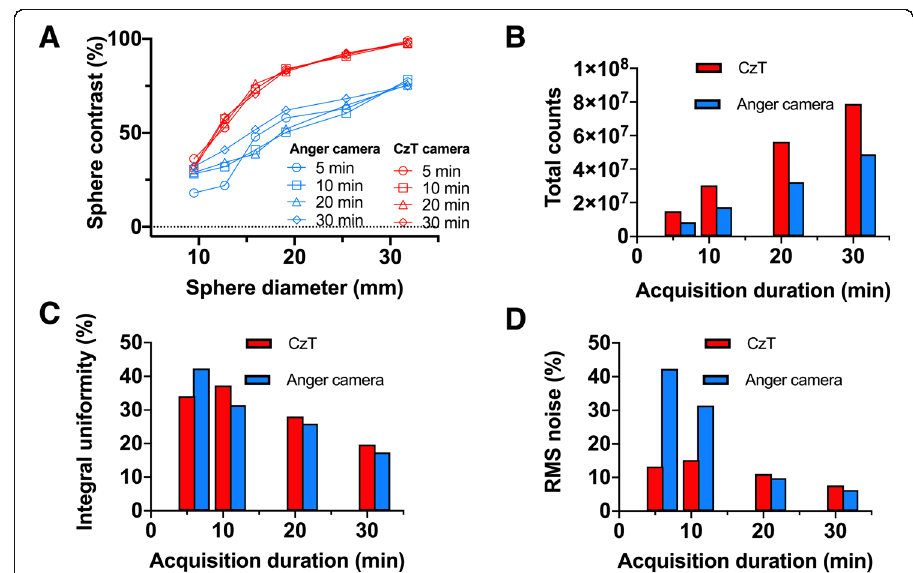
Fig. 4 Image contrast measured as a function of sphere diameter at different acquisition times for CzT and Anger cameras ( a ). Total recorded counts ( b ), integral uniformity ( c ), and RMS noise ( d ) calculated for different acquisition times for CzT and Anger